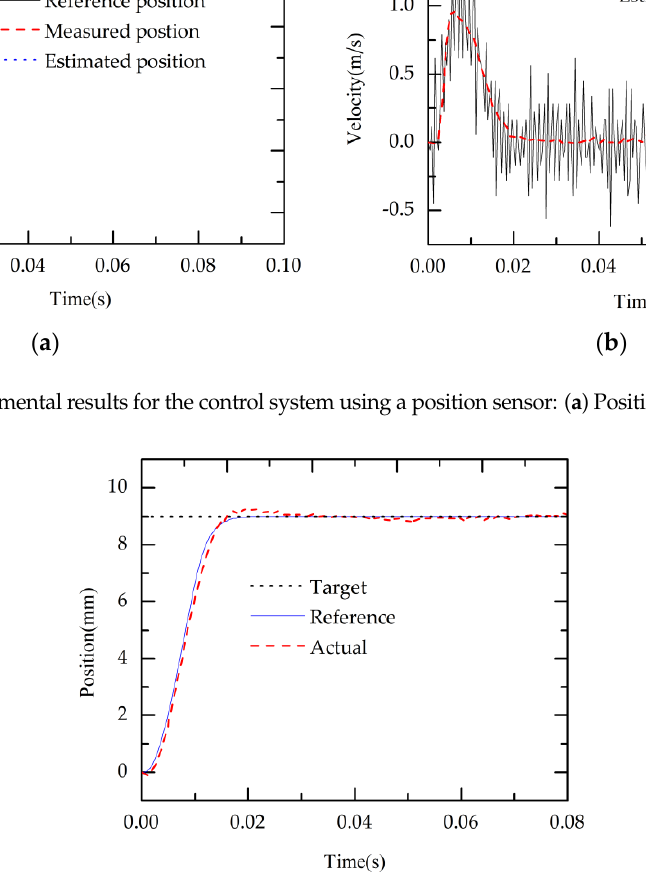
Figure 15. Experimental results for the control system using a velocity estimator.